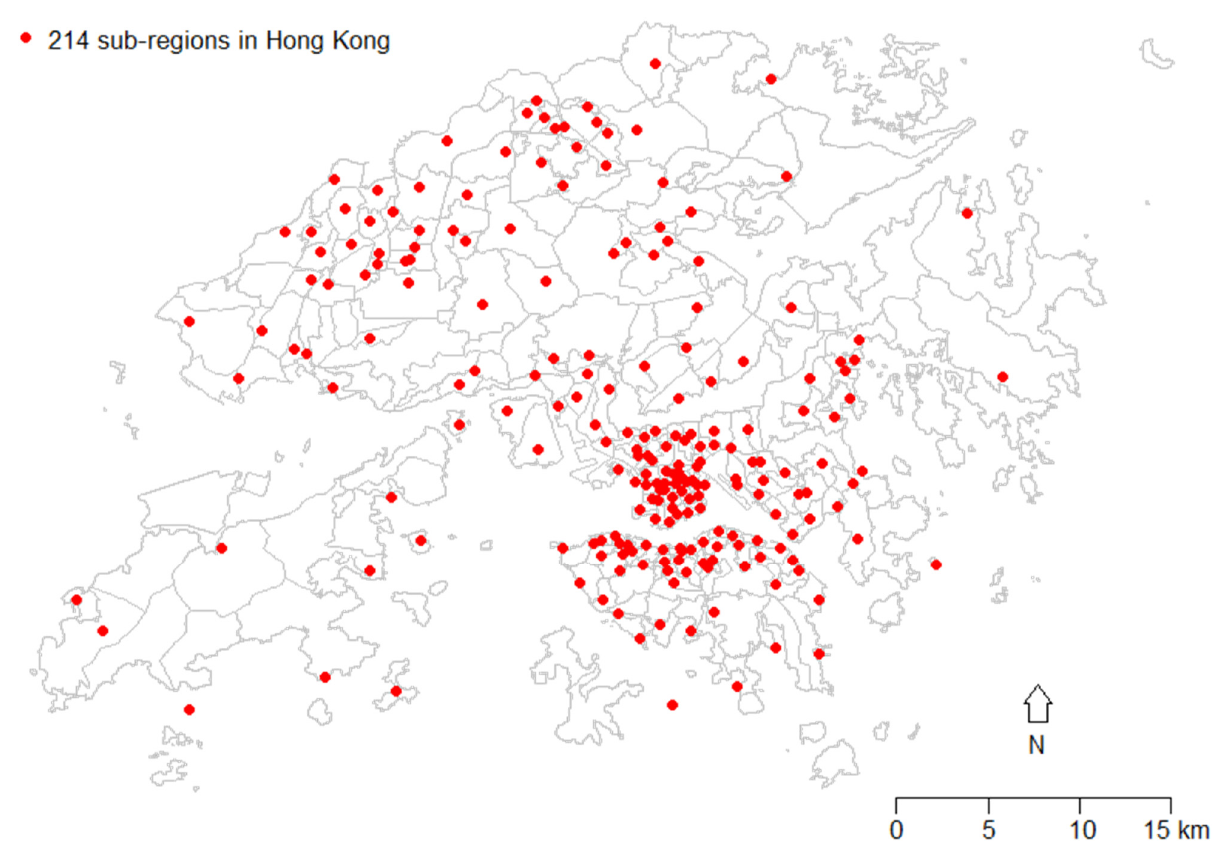
Figure 1. The map of 214 sub-regions in Hong Kong. Note: The red dots indicate the centroids of sub-regions, which are the geometric centers of the areas. Since some sub-regions contain multiple islands, the centers might be in the sea. In total, there were 214 red dots.